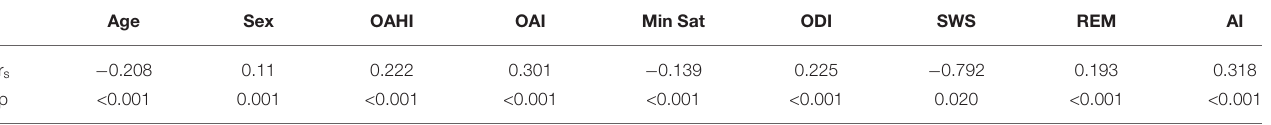
TABLE 3 | Simple correlation analysis (Spearman test) of the CAI and potential possible influencing factors in children with OSA. Age Sex OAHI OAI Min Sat ODI SWS